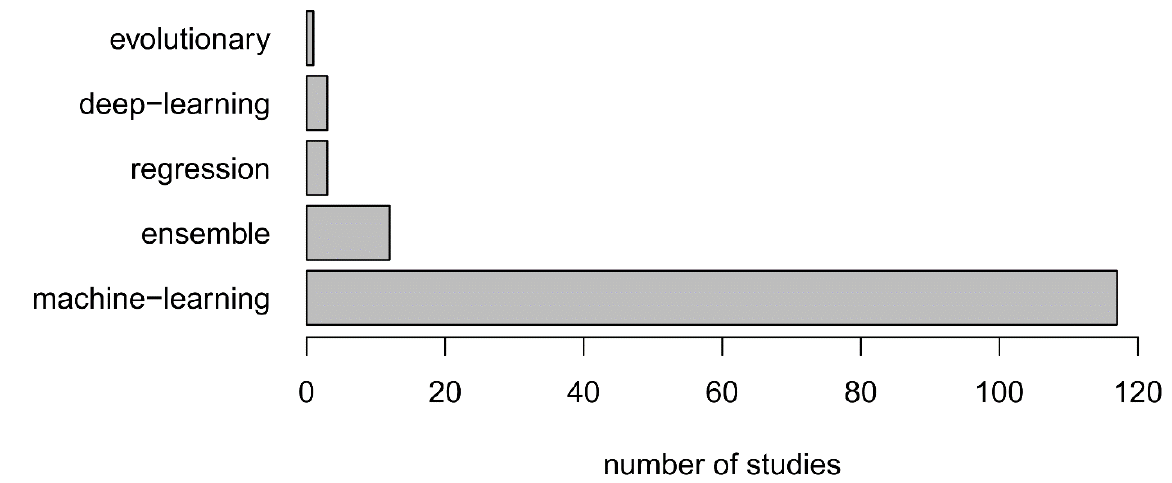
Figure 4. Number of studies reviewed by type of one-class classifier used.